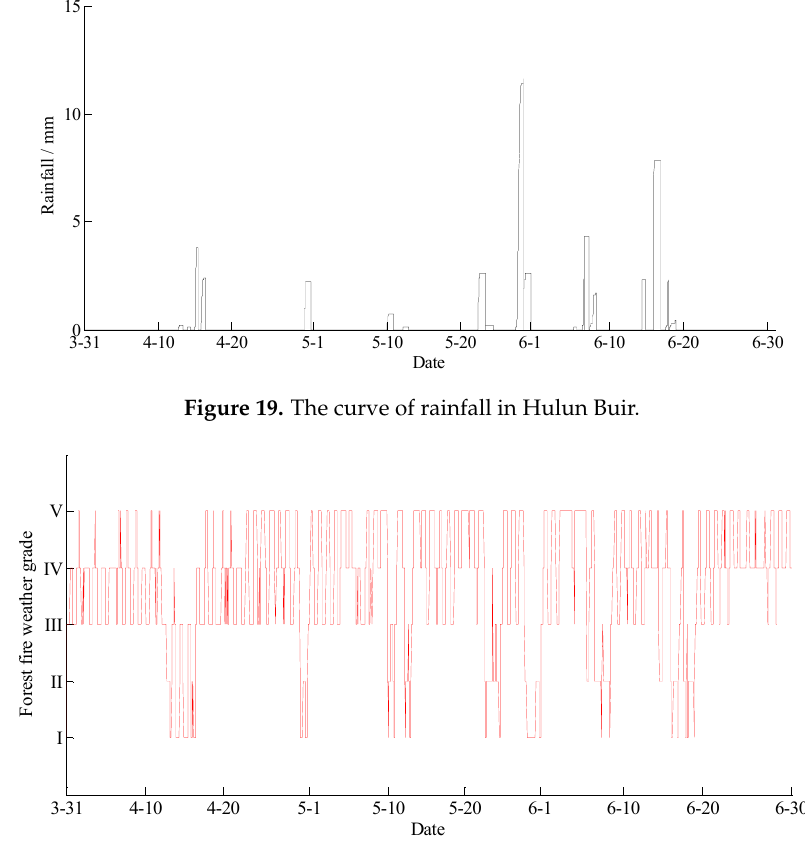
Figure 20. The curve of the forest fire weather grade in Hulun Buir.